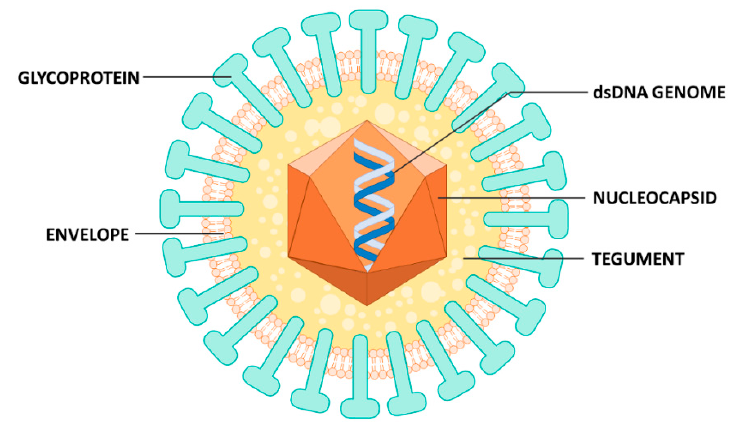
Figure 1. Structure of HCMV virion. Mature virions are coated by an envelope, from which viral glycoproteins protrude, and contain a double-stranded DNA genome enclosed within an icosahedral symmetry capsid, that is surrounded by tegument.